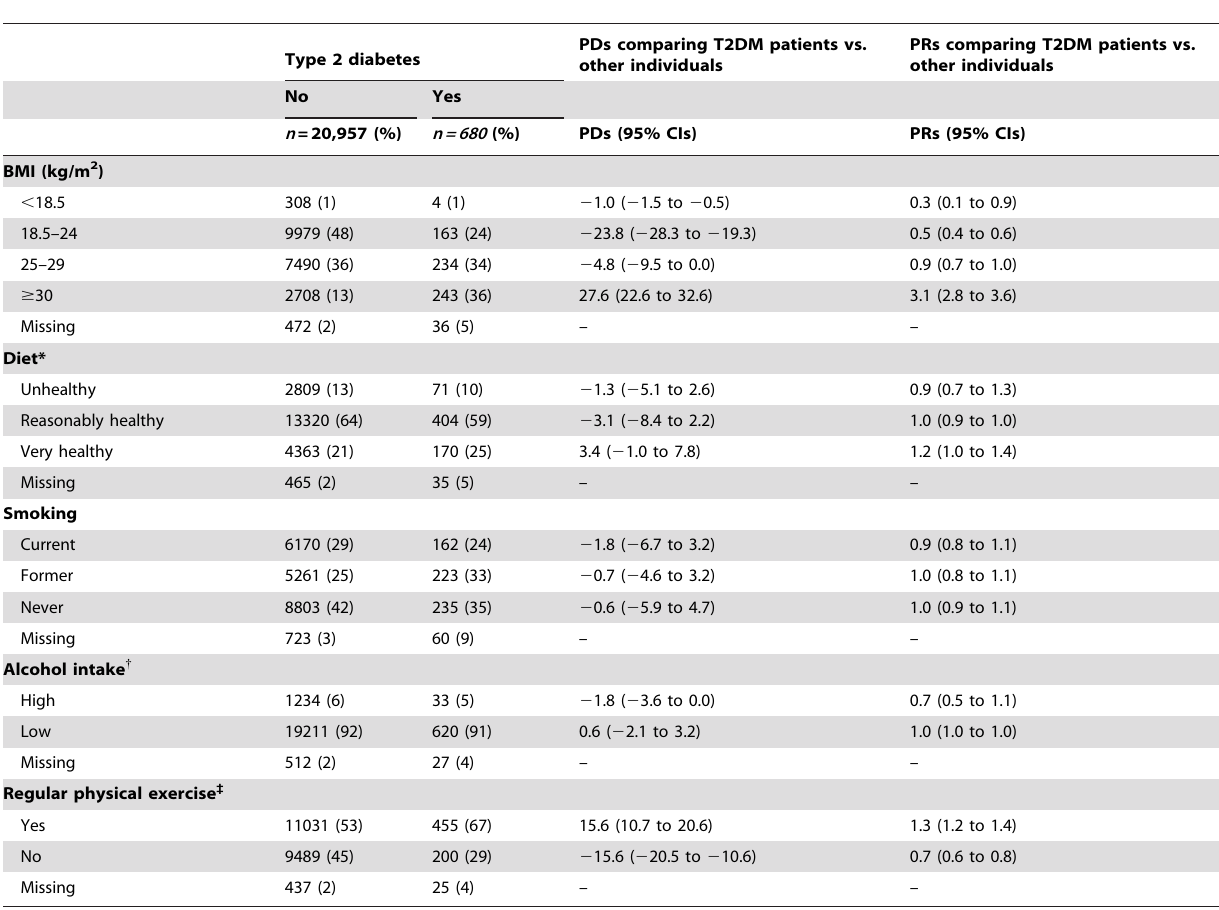
Table 2. Age-and gender-standardized prevalence differences (PDs) and prevalence ratios (PRs) of lifestyle factors according to type 2